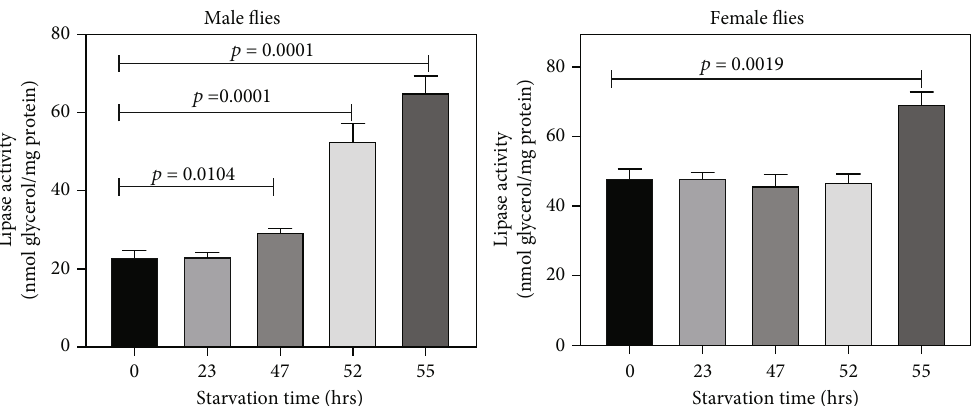
Figure 3: Lipase activity during starvation in 2 d old male and female fl ies. Lipase activity increased during the fi nal phase of starvation in both male and female fl ies. Lipase activity was analyzed in triplicate. The data is presented as the mean ± SD . It was analyzed by Student ’ s t -test; starvation vs. the control